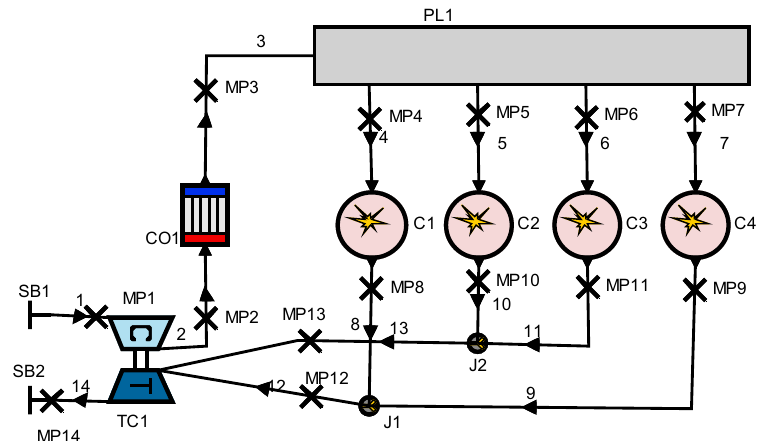
Figure 1. Simulation model of the entire diesel engine.